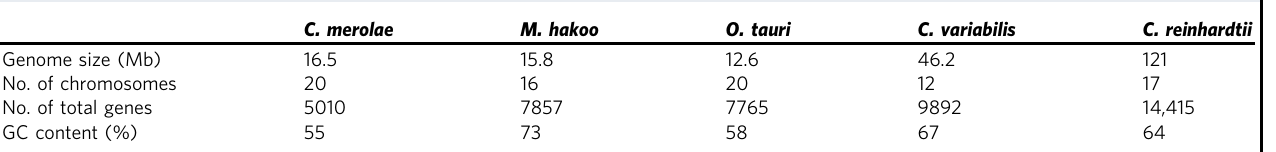
Relationship between the extremely high G + C content of the M. hakoo genome and the notable accumulation of the guanine